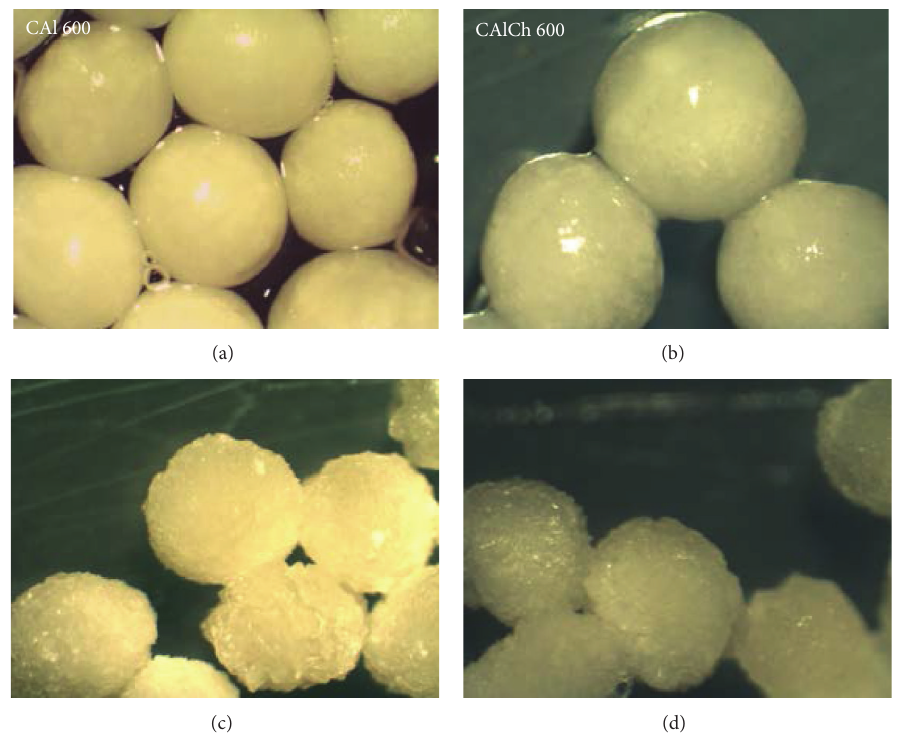
Figure 1: Stereomicroscopic images of wet (a-b) (2x magnification) and dry (c-d) (3x magnification) beads obtained using a needle of 600 𝜇 m in diameter.